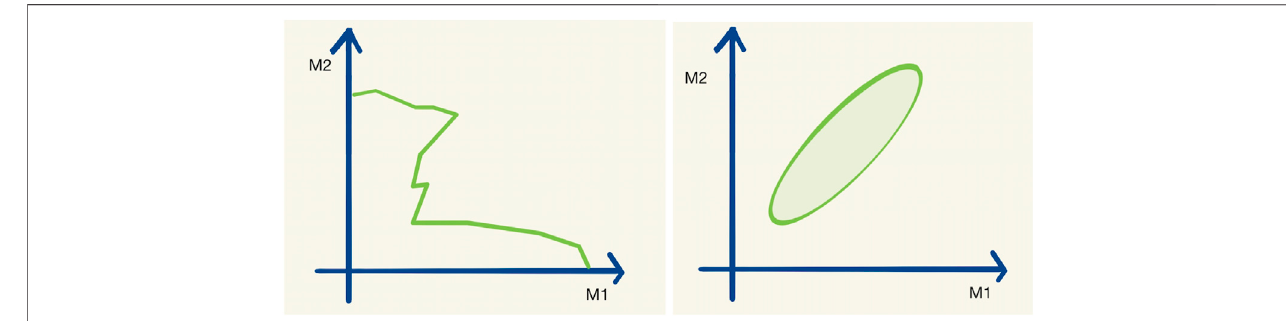
FIGURE1| Atypicalexclusionlimitcurve (left) andatypicalmaximumlikelihoodinterval (right) asafunctionofthetwoparametersM1andM2.Letusassumethat the hypothetical real physical model has 20 parameters M1 – M20.